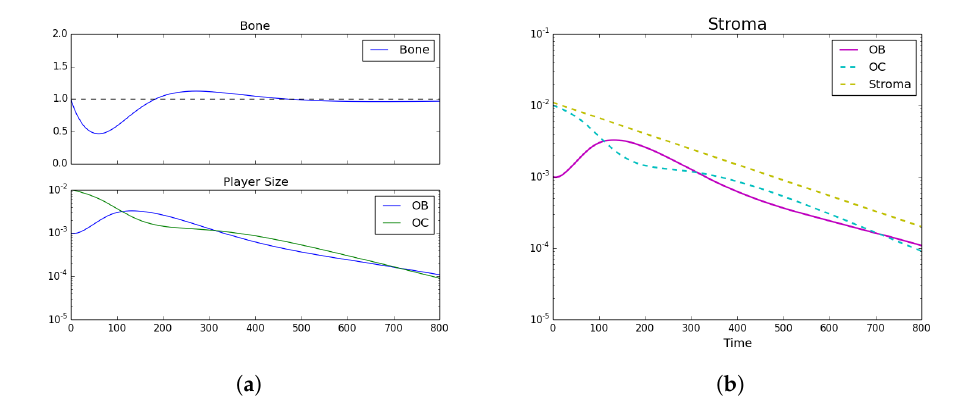
Figure 1. Tumor Introduction. ( a ) Bone size and strategy density; ( b ) stroma.Homeostatic populations were observed by setting ρ OB ( 0 ) = 0.001, ρ OC ( 0 ) = 0.01, ρ T ( 0 ) = ρ T